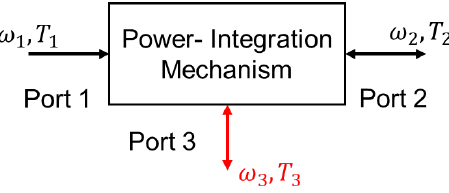
Figure 1. Power integration mechanism.